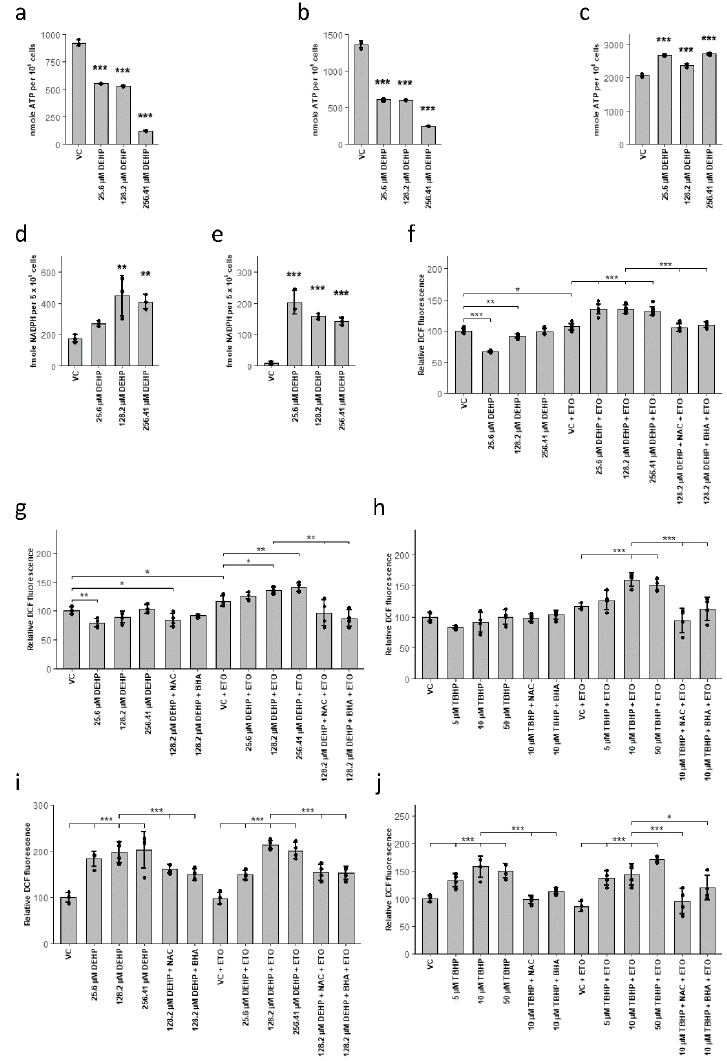
Figure 4. Increased oxidative stress leads to a shift from glycolysis to the pentose-phosphate pathway and ATP depletion in glycolytically active cells but not in cells capable of ATP production by fatty acid oxidation. ( a – c ) ATP levels after DEHP treatment of erythrocytes for 2d d ( a ), dendritic cells for 3 d ( b ), and neutrophils for 3 d ( c ). ( d , e ) NADPH levels after DEHP treatment of erythrocytes for 2 d ( d ) and dendritic cells for 3 d ( e ). ( f , g , i ) Relative fluorescence (DCF) in neutrophils ( f ), HepG2/C3A cells ( g ), and HUVECs ( i ) with or without preincubation with 5 µM etomoxir (ETO) and 250 µM N-acetylcysteine (NAC) or 10 µM butylated hydroxyanisole (BHA) for 2 h, followed by DEHP for 4 h ( h , j ). Relative fluorescence (DCF) in HepG2/C3A cells ( h ) and HUVECs ( j ) with or without preincubation with 5 µM ETO and 250 µM NAC or 10 µM BHA for 2 h, followed by tert-butyl hydroperoxide (TBHP) for 4 h. Data are presented as mean ± SEM; individual replicates are visualized as black dots in bar charts in case of n = 3. Statistical significance was determined by one-way ANOVA (* p < 0.05; ** p < 0.01; *** p < 0.001; n.s., not significant). Taken together, our results demonstrate that exposure to DEHP results in increased oxidative stress in all cell lineages. These responses are largely mediated by the MEHP- induced inhibition of SOD activity and may be a result of direct AhR antagonism. In- creased oxidative stress that develops in response to DEHP or other stimuli promotes an